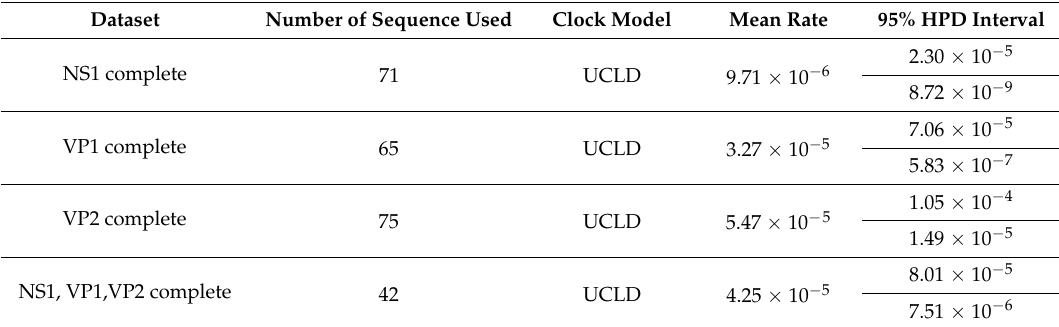
Table 3. Information on the evolutionary rate measured in this study and its analyzing method.